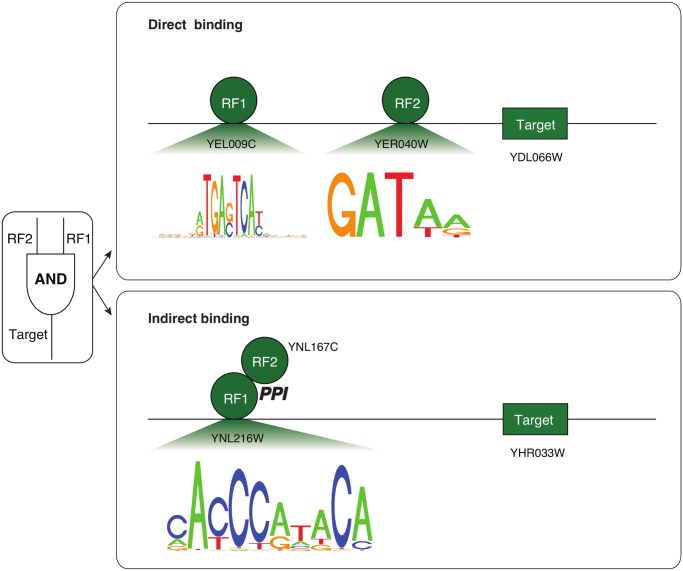
Promoter motifs for AND-consistent yeast triplets with directly and indirectly bound TFs.We present two example yeast triplets, (RF1 is the TF YEL009C, RF2 is the TF YER040W, T is the gene YDL066W) at top and (RF1 is the TF YNL216W, RF2 is the TF YNL167C, T is the gene YHR033W) at bottom, both of which are consistent with the AND gate by Loregic. Both TFs in the top triplet have motifs in the target promoter region, but only one TF, YNL216W, in the bottom triplet has a motif in the target promoter region. The other TF, YNL167C, cooperates with YNL216W in an AND logical relation via protein-protein interaction.